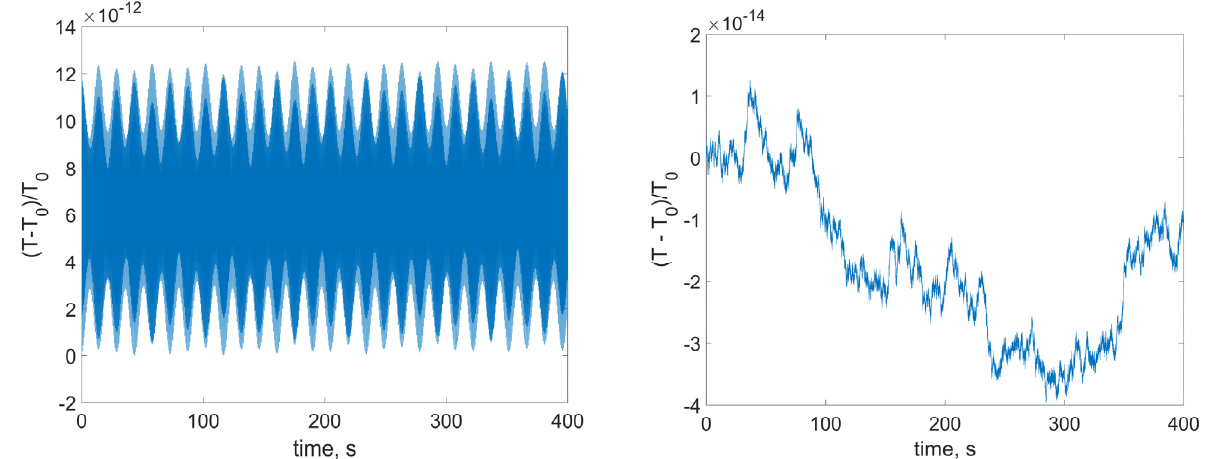
Figure 5. Relative variation of the total kinetic energy ( left ) h = 10 − 2 s and ( right ) h = 10 − 3